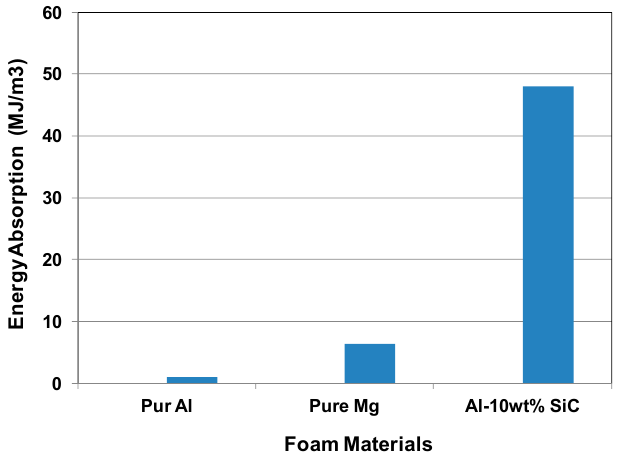
Figure 7. Energy absorption of produced foam materials.